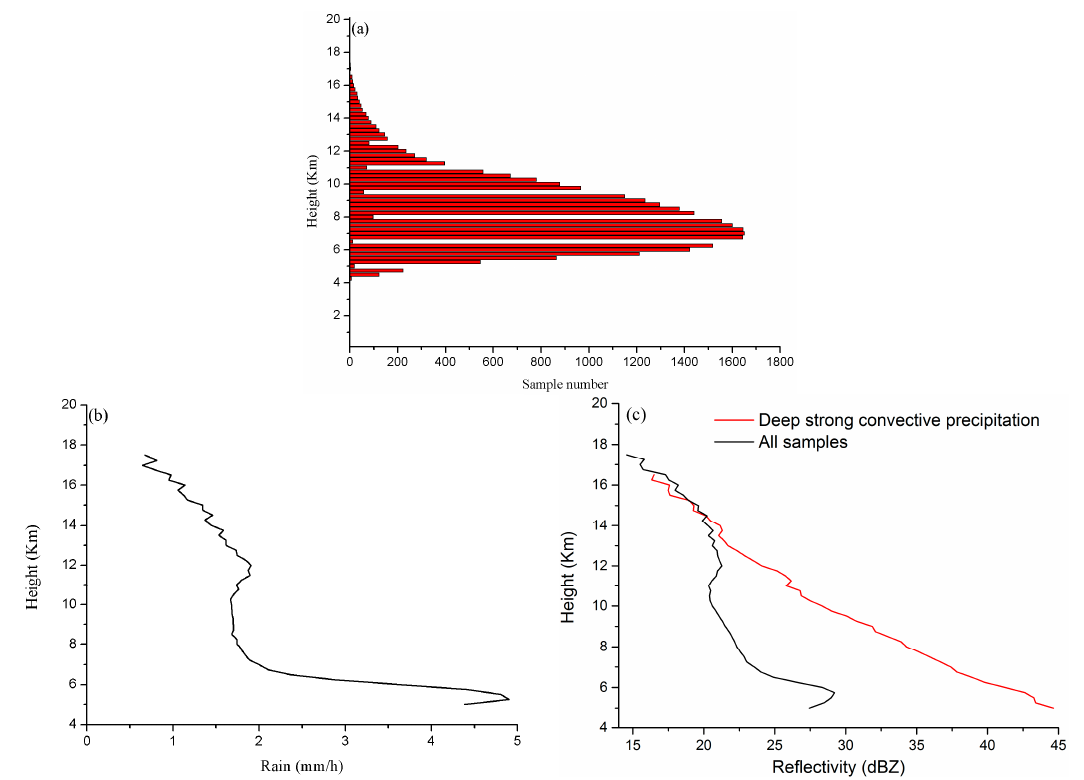
Figure 6. ( a ) Vertical distribution of the number of samples; ( b ) Mean rainfall profiles and ( c ) average attenuation-corrected reflectivity profiles (Black curve shows the mean value of all samples, corresponding to the mean rainfall profiles ( b ), and red curve shows the mean value of deep strong convective precipitation.) of the heavy rain event over the eastern Tibetan Plateau.